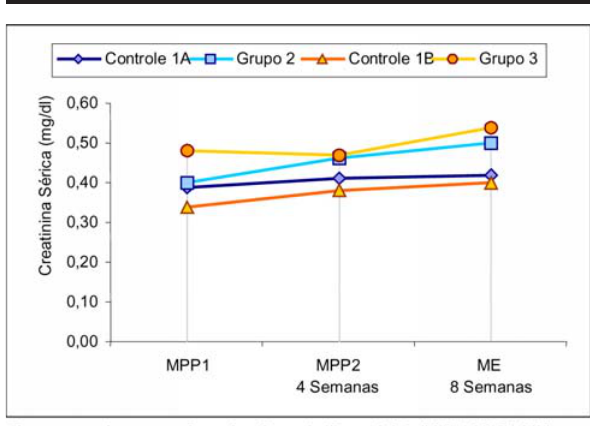
FIGURE 1 - Serum creatinine evolution among the 3 groups